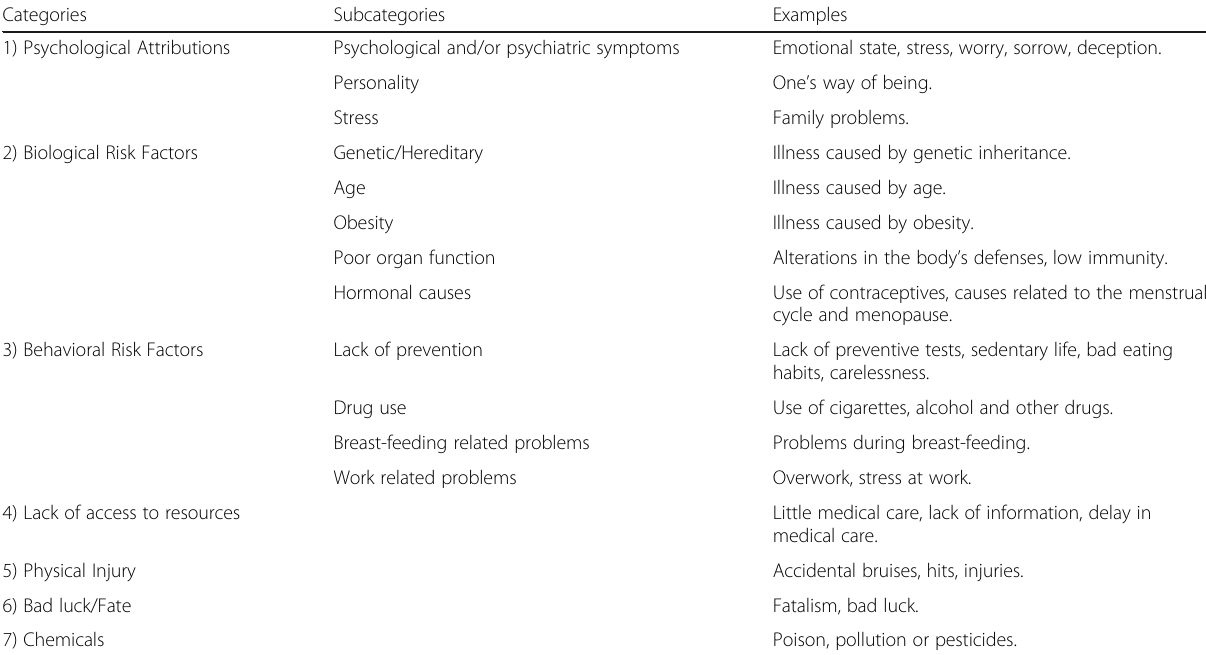
Table 1 Categories, subcategories, and examples of causes attributed to breast cancer Categories Examples